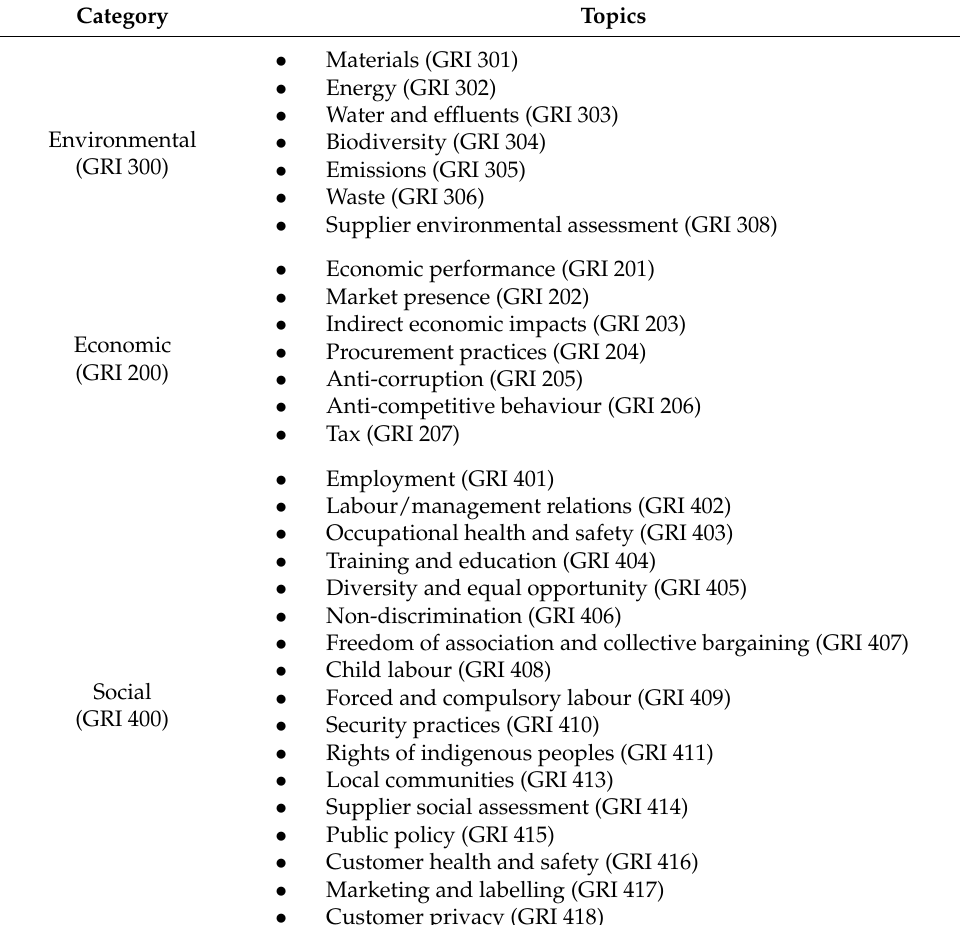
Table 1. Specific topics of GRI